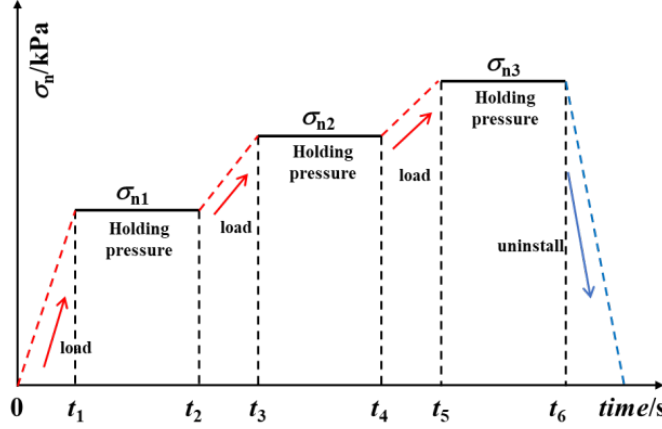
Figure 8. Variable normal stress continuous multi-stage loading.